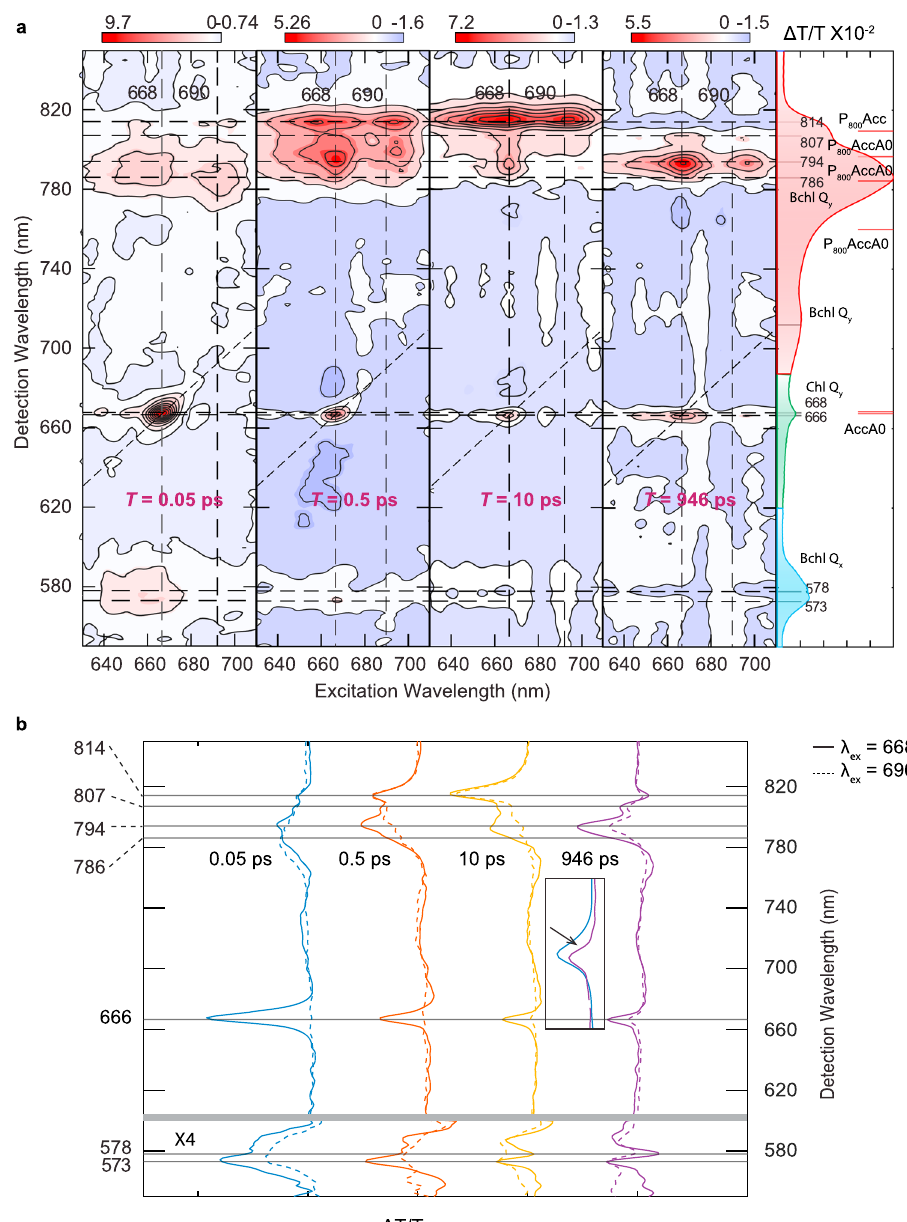
Fig. 2 2DES probes the photoexcited dynamics in the HbRC at 77 K. a 2DES absorptive spectra at 0.05, 0.5, 10, and 946 ps. Alongside the 2D absorptive spectra are the experimental absorption spectrum and the simulated stick spectrum (red lines) of Kimura et al. 8 . The dashed lines in the 2DES and the gray lines in the absorption spectrum indicate the various peak positions discussed in the main text. The experimental absorption spectrum is divided into three color-coded regions based on their dominant contributions (i.e., red — the Bchl Q y band; green — the Chl Q y band; blue — the Bchl Q x band). The contour levels are − 1:0.1:1 of the maximum amplitude. b The slice spectra under excitation at 668 nm (dashed) and 690 nm (dashed) at various T extracted from the 2DES absorptive spectra. The derivative lineshapes at 573, 578 nm and the blue-shifted A 0 peak at 666 nm (inset) are induced by the Stark effect. These features are fi ngerprints for the charge-separated